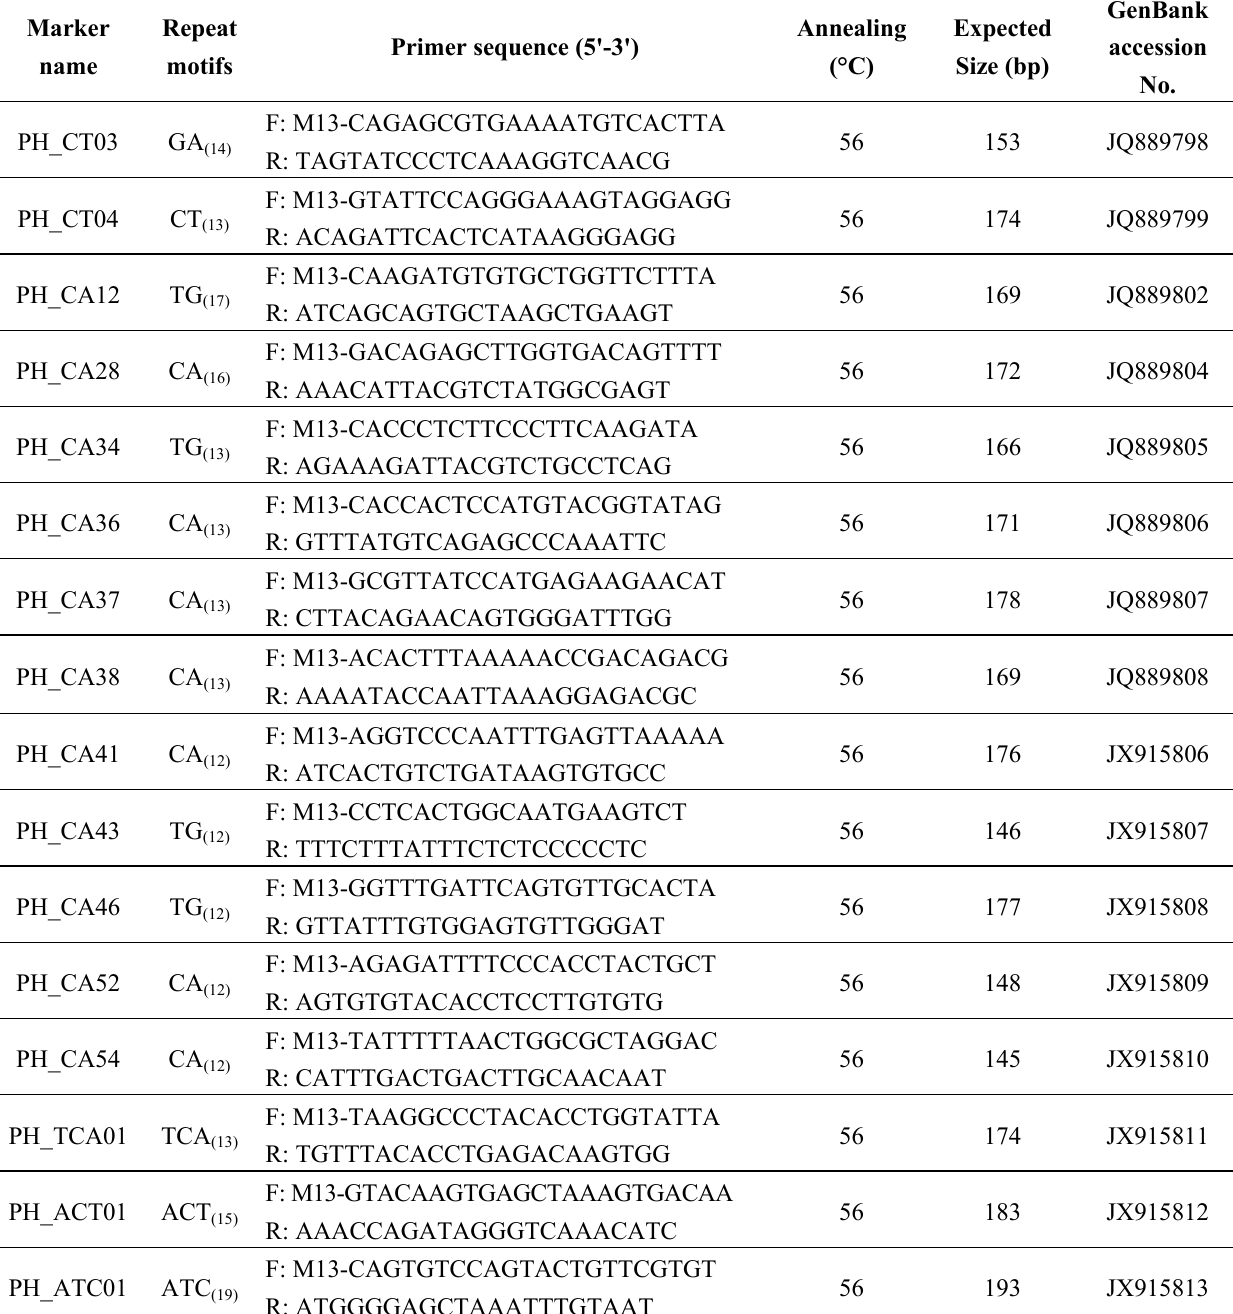
Table 1. The set of 16 microsatellite markers developed in Pungtungia herzi